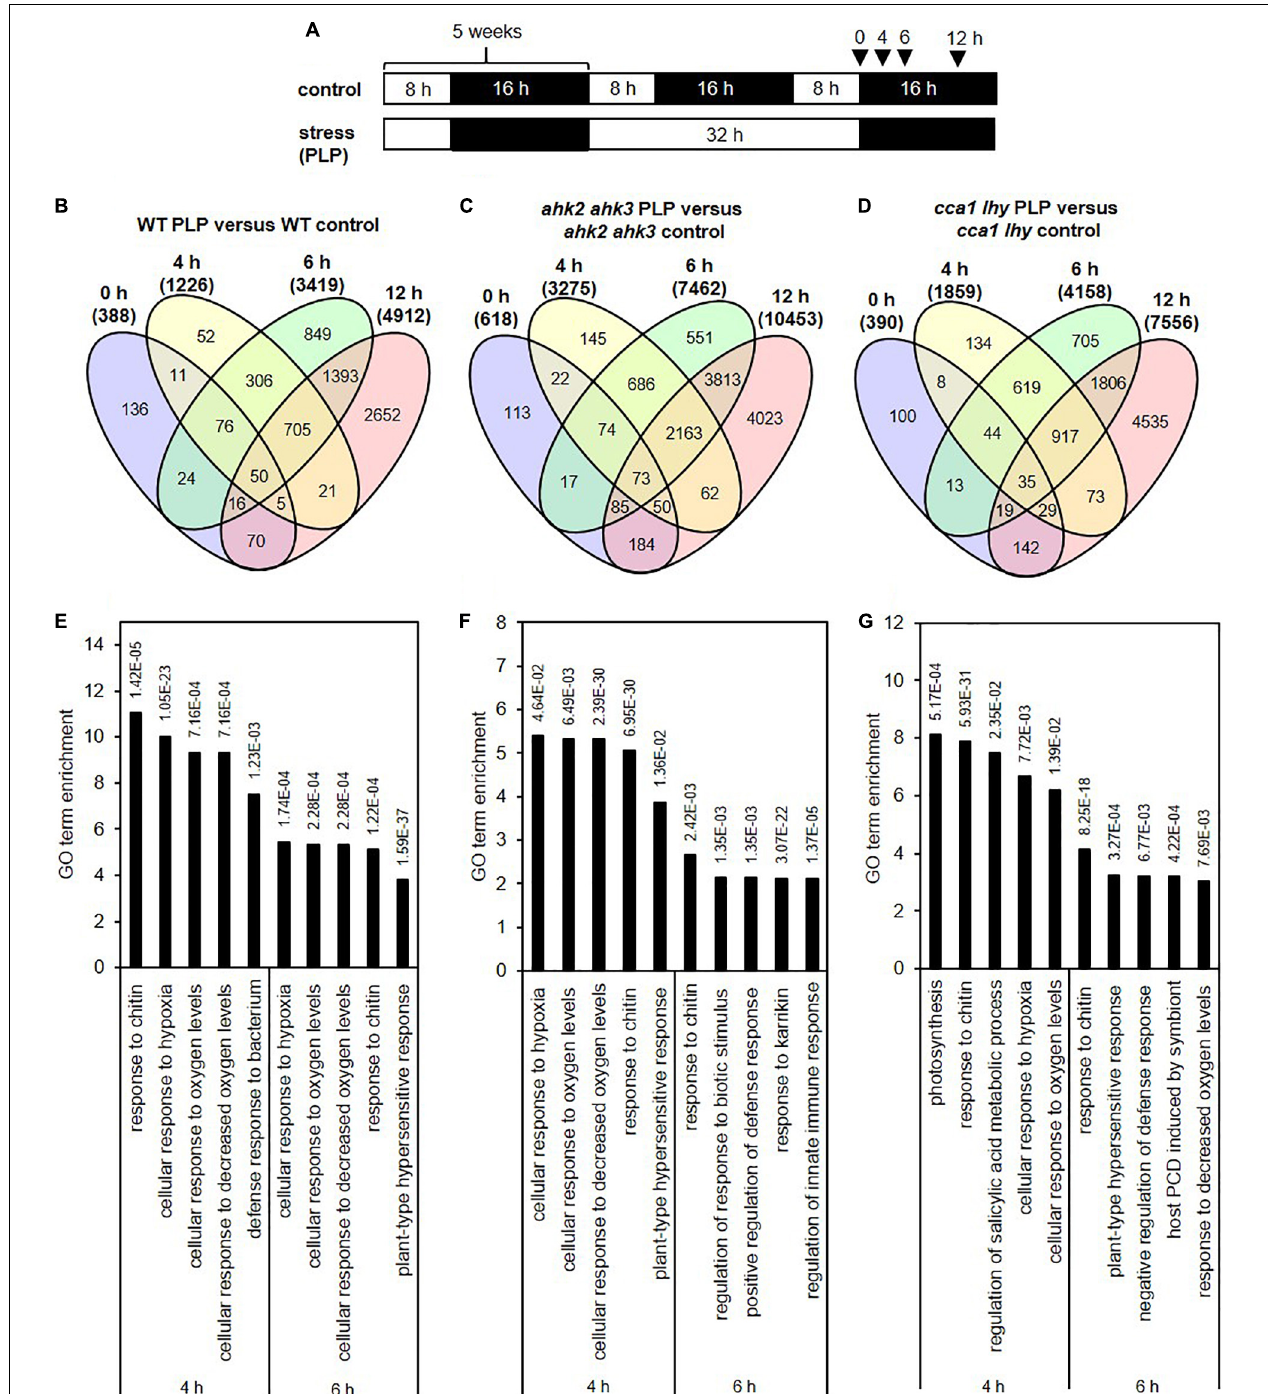
FIGURE 1 | Significantly regulated genes in WT, ahk2 ahk3 and cca1 lhy after photoperiod stress. (A) Experimental setup used in this study. 5-week-old short-day (SD)-grown plants were exposed to a prolonged light period (PLP) of 32 h followed by a normal SD night. White, light period; black, dark period. Arrows indicate sampling time points for RNA analysis. (B–D) Venn diagrams showing the overlap of DEGs at different time points for WT (B) , ahk2 ahk3 (C) and cca1 lhy (D) . Numbers in brackets indicate the total number of DEGs (| fold-change| = 2; Bonferroni-corrected p -value ≤ 0.05) in PLP-treated plants compared with control plants at the different time points. (E–G) Top 5 GO enrichment terms for time point 4 and 6 h for WT (E) , ahk2 ahk3 (F) and cca1 lhy (G) . A list of top-5 GO enrichment terms pro timepoint can be found in Supplementary Table 2 . An overview of the gene regulation for the comparisons between PLP and control treatments for WT, ahk2 ahk3 and cca1 lhy is shown for all time points in Supplementary Data 2 . A core-set of photoperiod stress-responsive genes is listed in Supplementary Table 3 and the top 20 most highly regulated genes at each time point are listed in Supplementary Tables 6–11 .